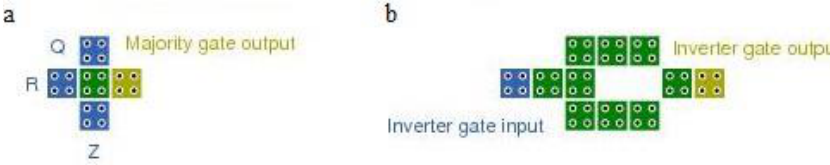
Figure 2. ( a ) Majority gate and ( b ) inverter gate in QCA technology.